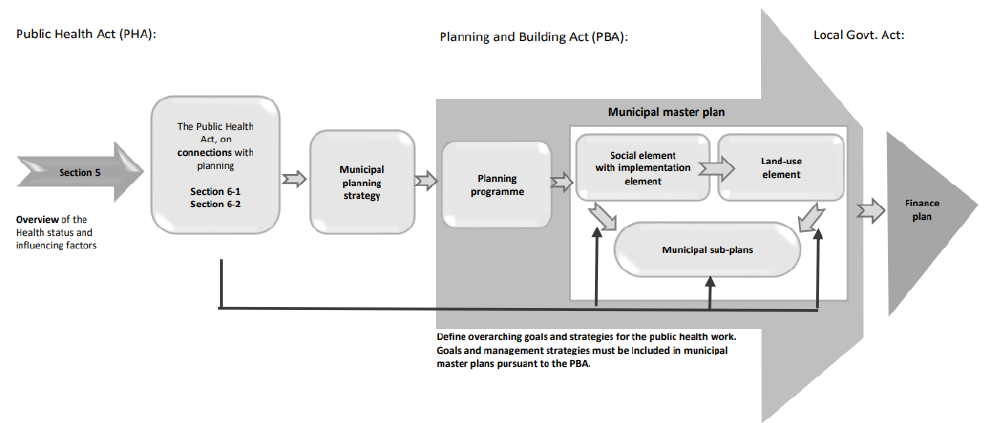
Figure 1. Model visualizing the municipal plan process and the relatedness between the Public Health Act and the Planning and Building Act (Adapted from [25,26]).